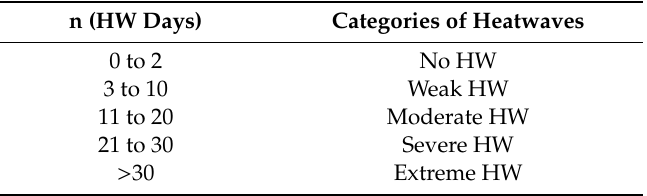
Table 5. Classification of heatwaves (HW) according to the total number (n) of HW days in the season. n (HW